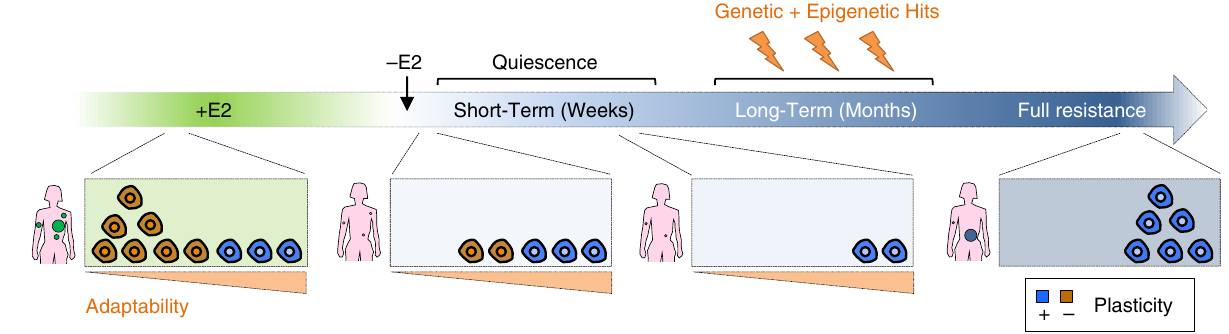
Fig. 8 Proposed multi-step model of resistance to endocrine therapies. (Left to right). A hierarchy of cells with or without features of plasticity (in blue and brown) co-exist in the primary tumour and in the micro-metastases (large and small green circles, respectively). These cells are already positioned on a gradient of probability to survive to future exposure to endocrine therapies (light green box). Upon surgery and start of adjuvant treatment ( − E2), only a handful of plastic cells is able to survive (light blue boxes). These cells enrich for the transcriptional signature of pre-adaptation identi fi ed in this work, and in turn are those able to accumulate those genetic hits and further transcriptional re-wiring observed in the fully resistant cells, which eventually lead to metastasis (large blue